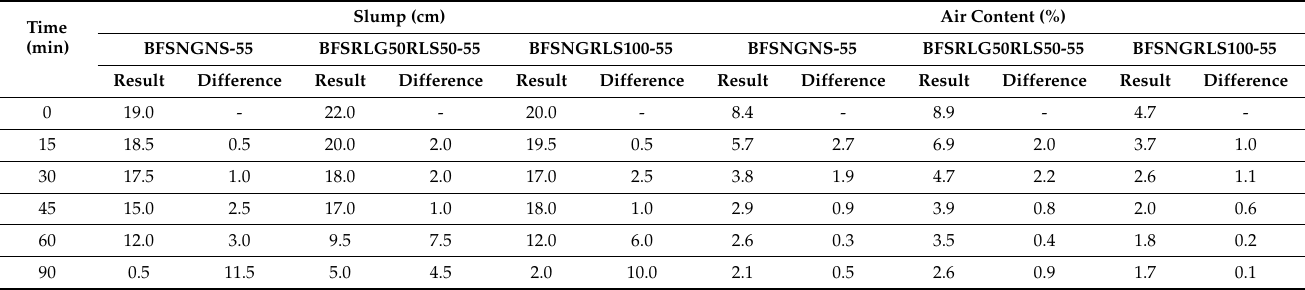
Table 11. Change of slump and air content with